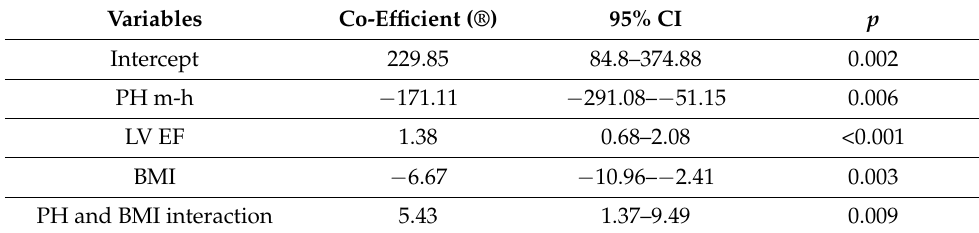
Table 7. Multivariate linear regression for PaO 2 during